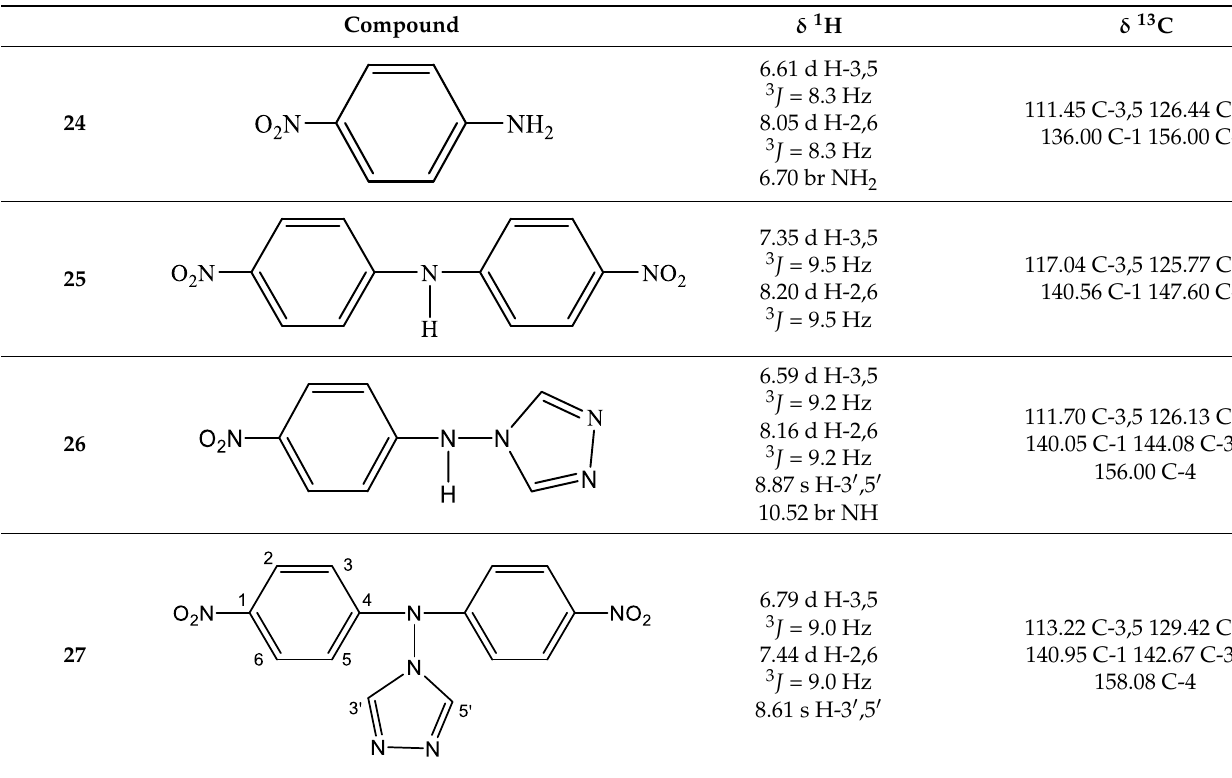
Table 2. 1 H and 13 C NMR chemical shifts of nitrobenzene amination products (ppm) (DMSO- d 6 ).